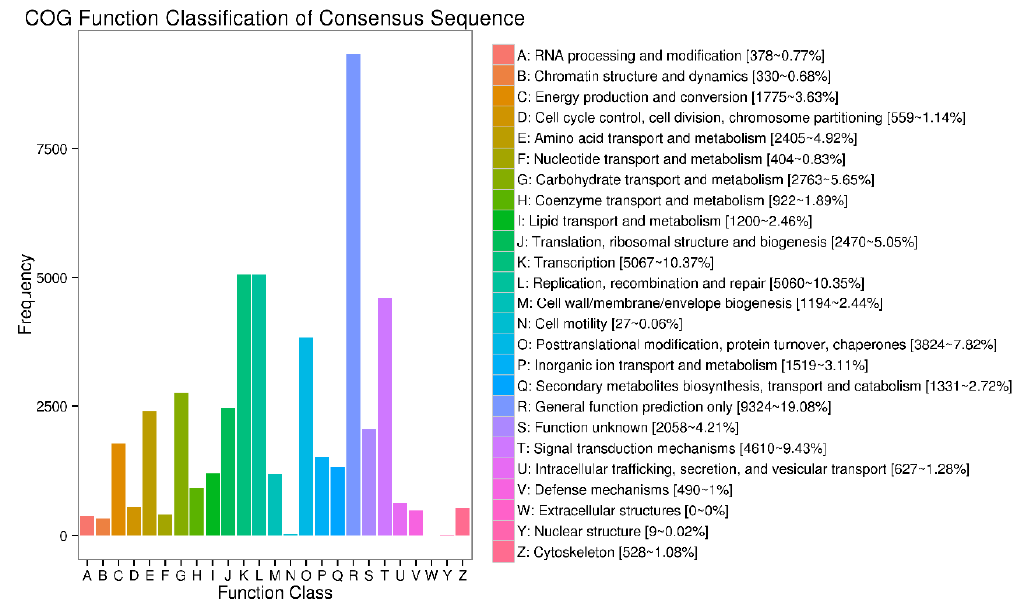
Figure A5. COG function classification of the annotated high-quality transcripts obtained by TGS. The horizontal axis represents the COG categories and horizontal axis represents the gene number.